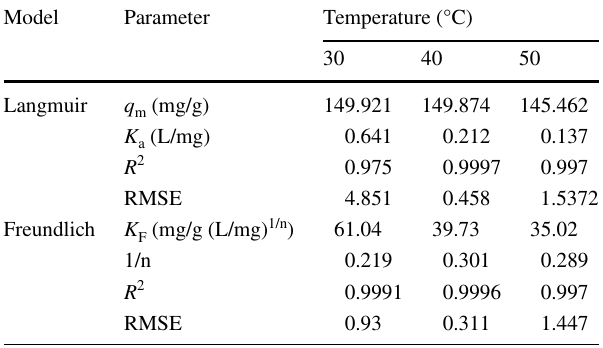
Table 2 Langmuir and Freundlich isotherm parameters for MB adsorption on BNH-CM at different temperatures Model